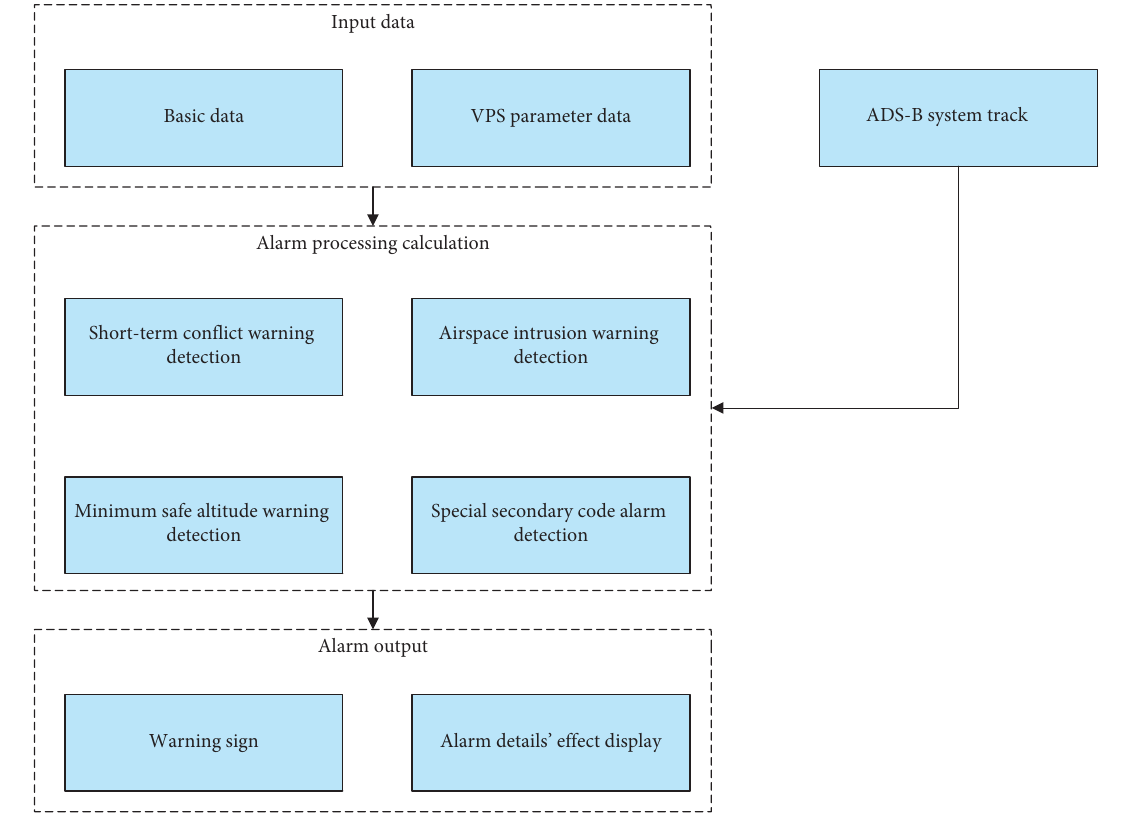
Figure 6: Processing view of ADS-B flight safety warning system.